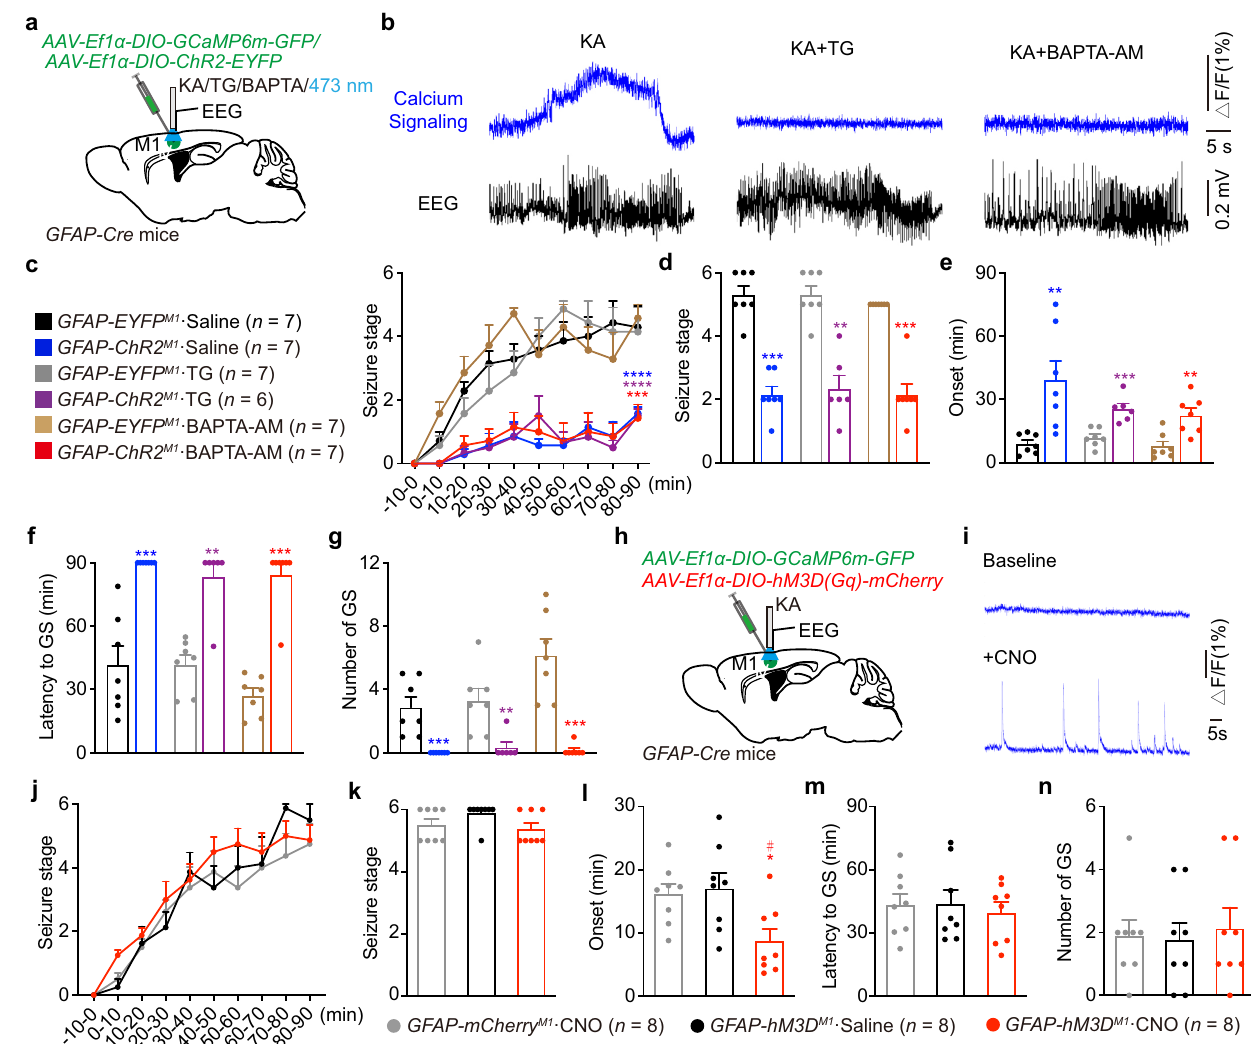
Fig.4|Astrocyticcalciumsignalingisnotrequiredtoproducetheanti-seizure effectsinducedbyoptogeneticstimulationofastrocytes.a GFAP-Cre micewere injected with Cre-dependent virus expressing GCAMP6m-GFP or ChR2-EYFP in the M1 and implanted with cannula and electrode for drug injection, blue light stimu- lationandEEGrecording. b TypicalcalciumsignalsandcorrespondingseizureEEGs in KAor KA+TG/BAPTA-AMinjectiongroups. Δ F/F represents the changeinsignal amplitudefromthebaselevel. c Effectsofoptogeneticstimulationofastrocyteson the development of seizure stage, in the condition of calcium signaling inhibition by TG orBAPTA-AMinjection. d – g Effects of optogeneticstimulationof astrocytes on seizure stage ( d ), EEG onset ( e ), latency to GS ( f ) and number of GSs ( g ), in the conditionof calciumsignalinginhibitionbyTGorBAPTA-AMinjection. h GFAP-Cre mice were injected with Cre-dependent virus expressing GCAMP6m-GFP and/or